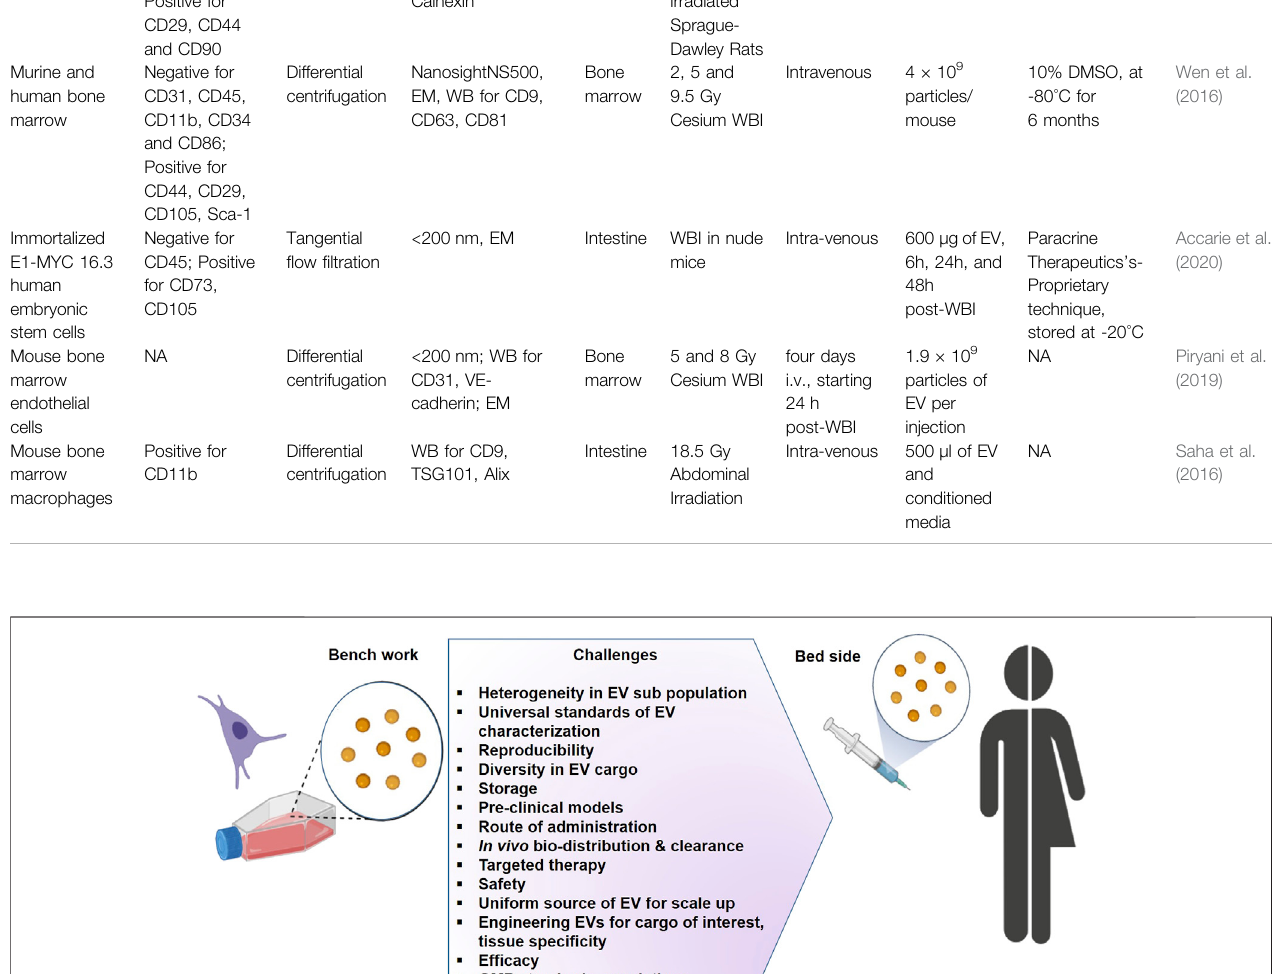
Frontiers in Pharmacology |